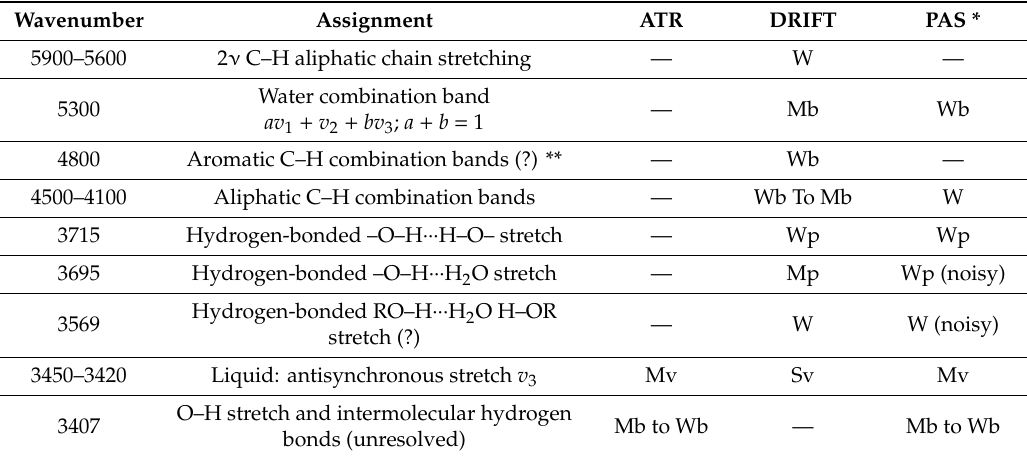
Table 5. The assignment of major bands common to most ND brands